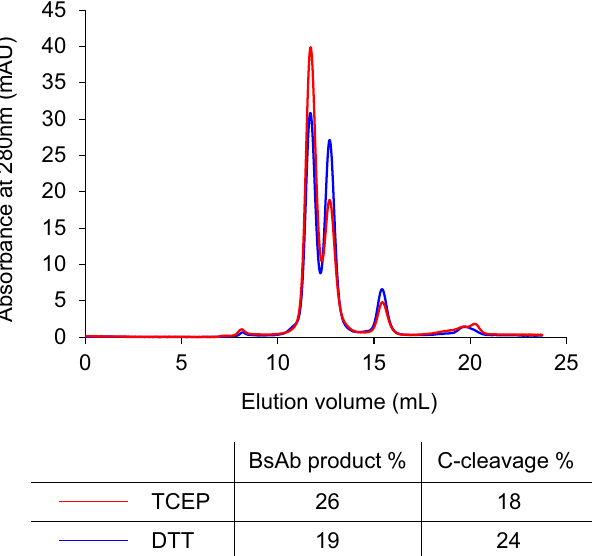
Figure 4. Comparison of the effect of DTT (blue) and TCEP (red) as the reducing agent via size-exclusion chromatography. Values of % yield of the BsAb product and C-cleaved side product were determined as the ratio of the products to the precursor Int C /Fab #1 -Fc in mol. The quantity of the product was calculated from the area under the